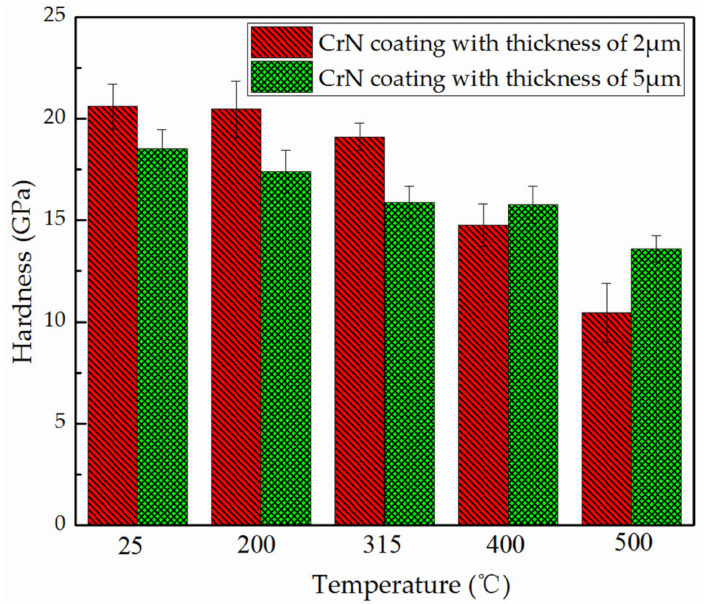
Figure 4. Hardness of CrN coating as a function of